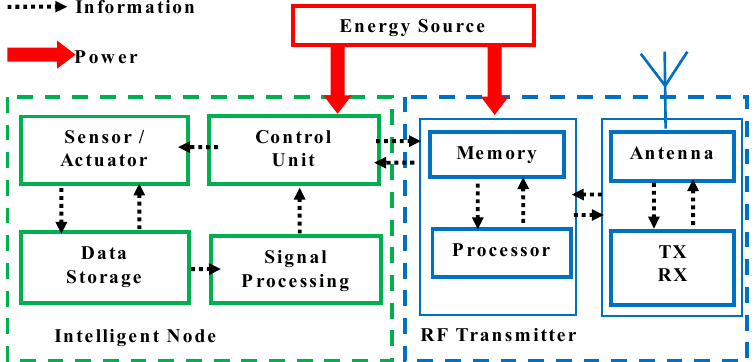
Figure 4. Basic architecture of a WSAN node.